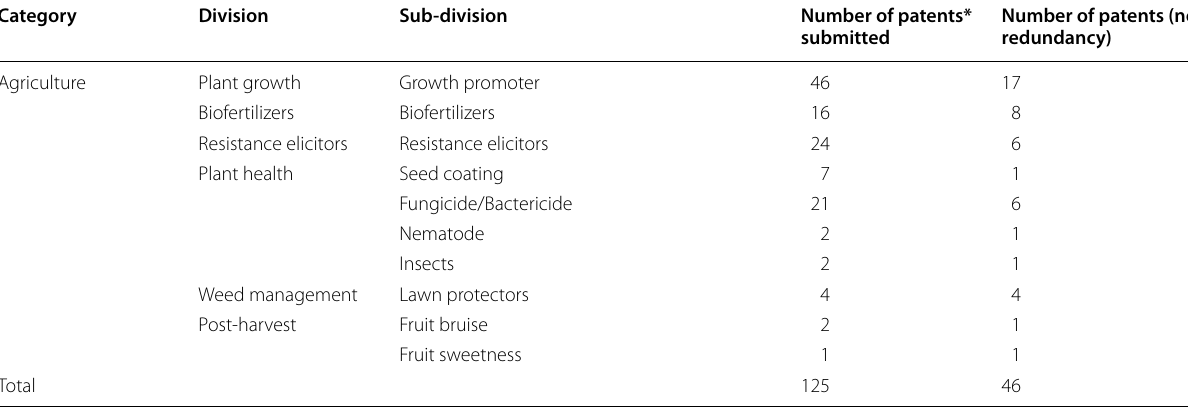
* patents related to microalgal protocols or products used in agriculture